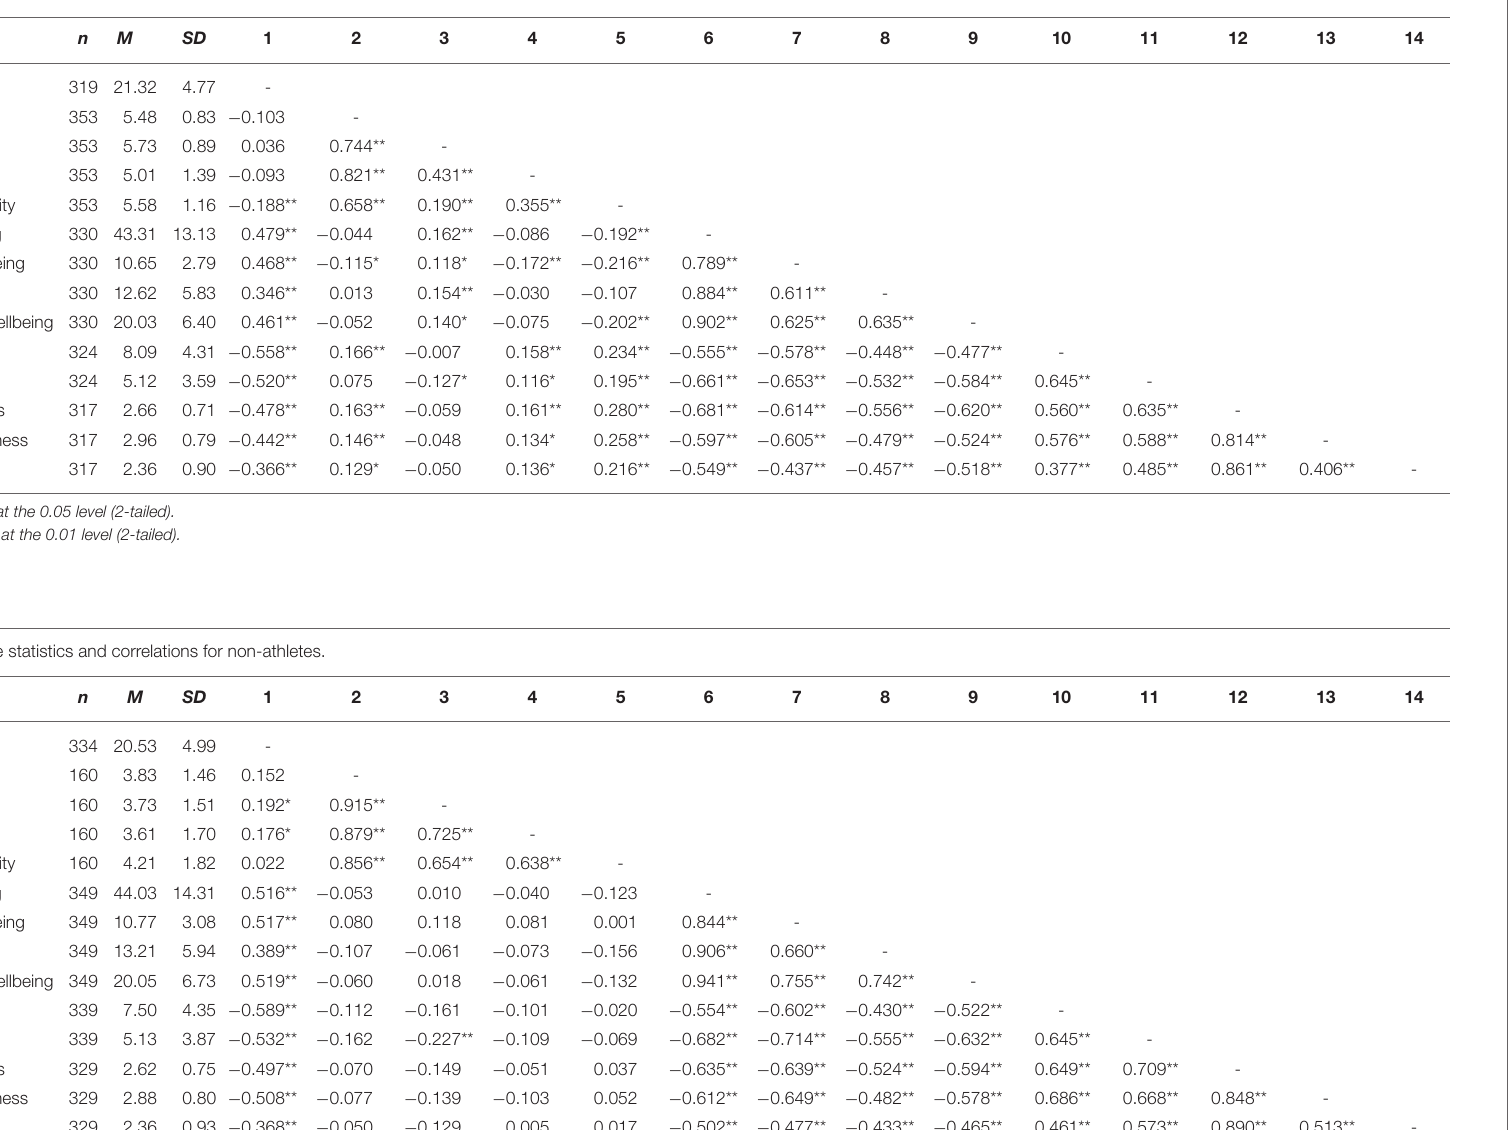
TABLE 2 | Descriptive statistics and correlations for athletes.